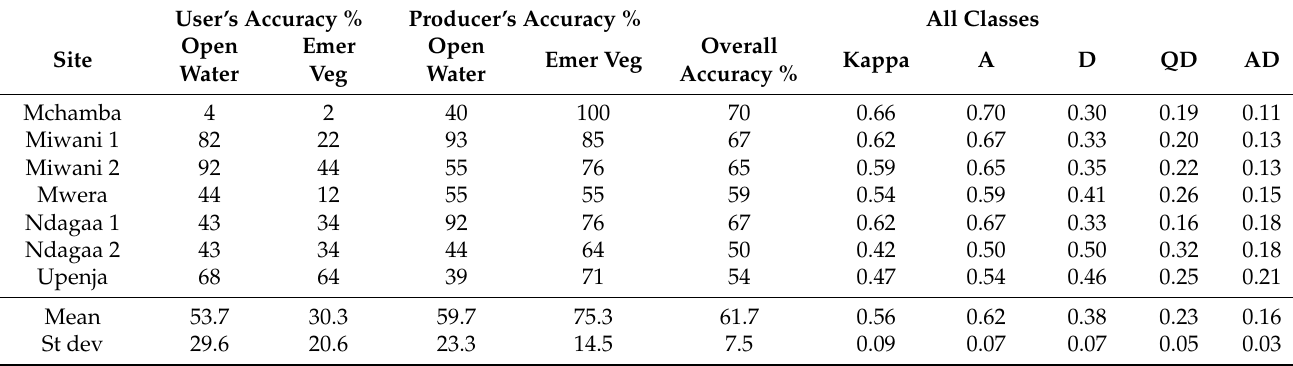
Table 4. Summary of supervised classification accuracy results, with specific focus on land cover classes relevant to potential mosquito larval habitats: open water and emergent vegetation, where A = Overall Agreement, D = Overall Disagreement, QD = Overall Quantity Disagreement, AD = Over- all Allocation